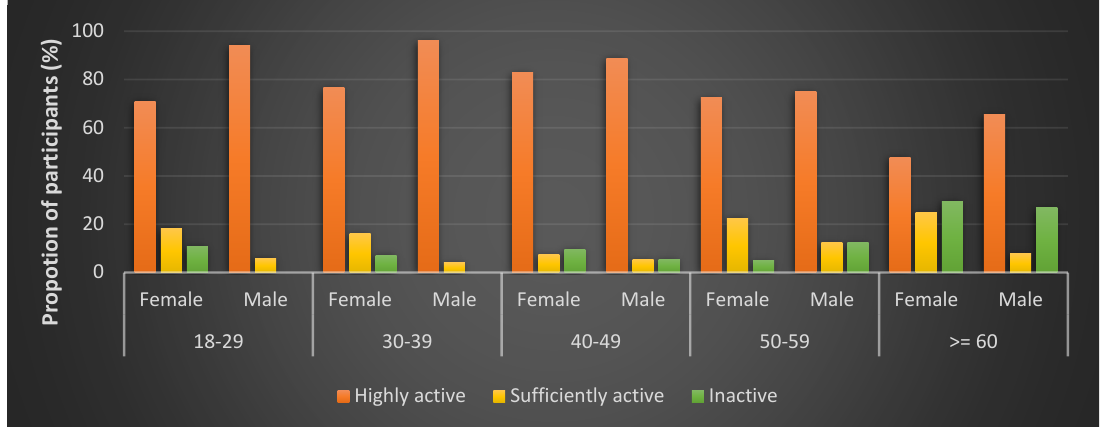
Figure 2. Physical activity classification by age and gender.